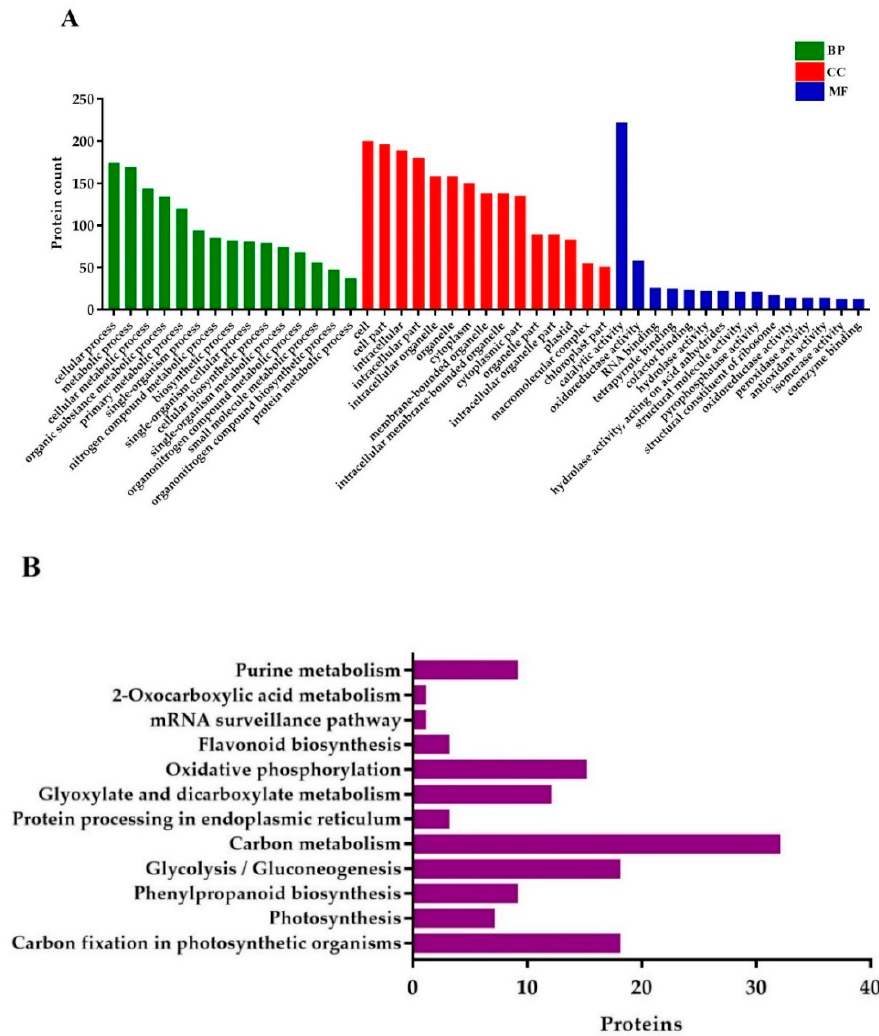
Figure 7. Gene ontology (GO) and KEGG (Kyoto Encyclopedia of Genes and Genomes) pathway enrichment analysis of DEPs. ( A ) GO annotations of the DEPs, and ( B ) the histogram of KEGG pathway enrichment, with the bar showing the number of proteins. BP; biological processes, CC; cellular components, and MF; molecular functions.